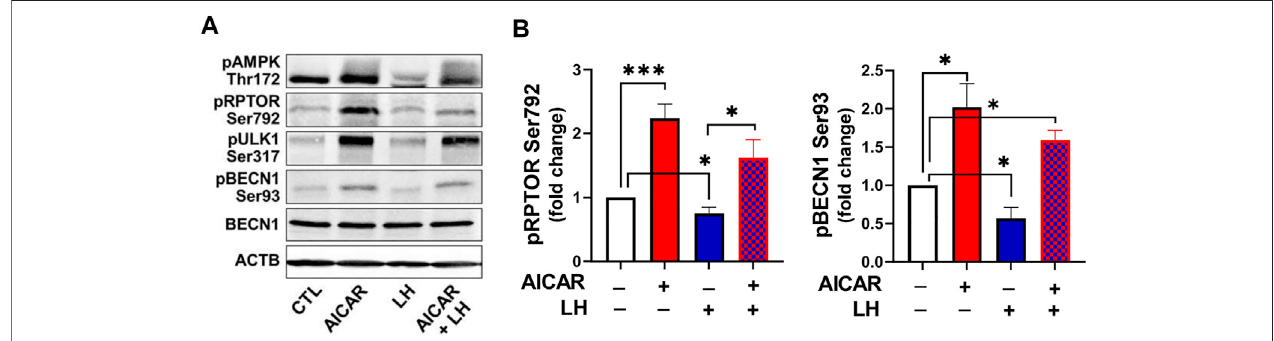
FIGURE10| ActivationofAMPKabolishedLH-mediatedphosphorylationofAMPK α ,RPTORandBECN1.SmalllutealcellswerepretreatedwithAICAR(1 mM)for 1 h and then treated with LH (10 ng/ml) for 4 h. Representative blots (A) and bar graphs (B) showing phosphorylation of AMPK α (Thr172) and the AMPK substrate RPTOR (Ser792) and BECN1 (Ser93). Bar graphs show average fold changes ± SEM from 3 to 5 separate experiments. Data were normalized to β -actin. Statistical analysiswasperformedusing one-wayANOVAtestforrepeatedmeasurementsandBonferroniposthoctest. Signi fi cantdifferencesareindicatedwithasterisks*, *** representing p < 0.05, p < 0.001.